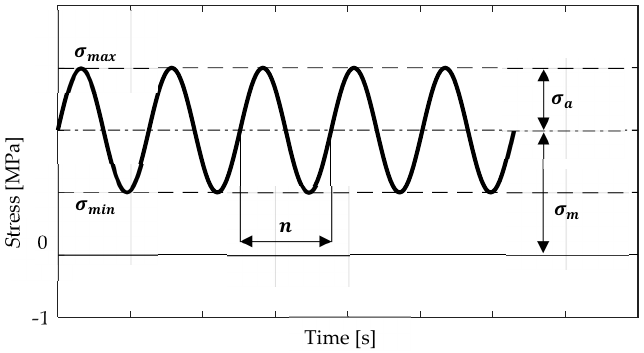
Figure 16. Characterization of fatigue loading and relationship between the parameters in Equation